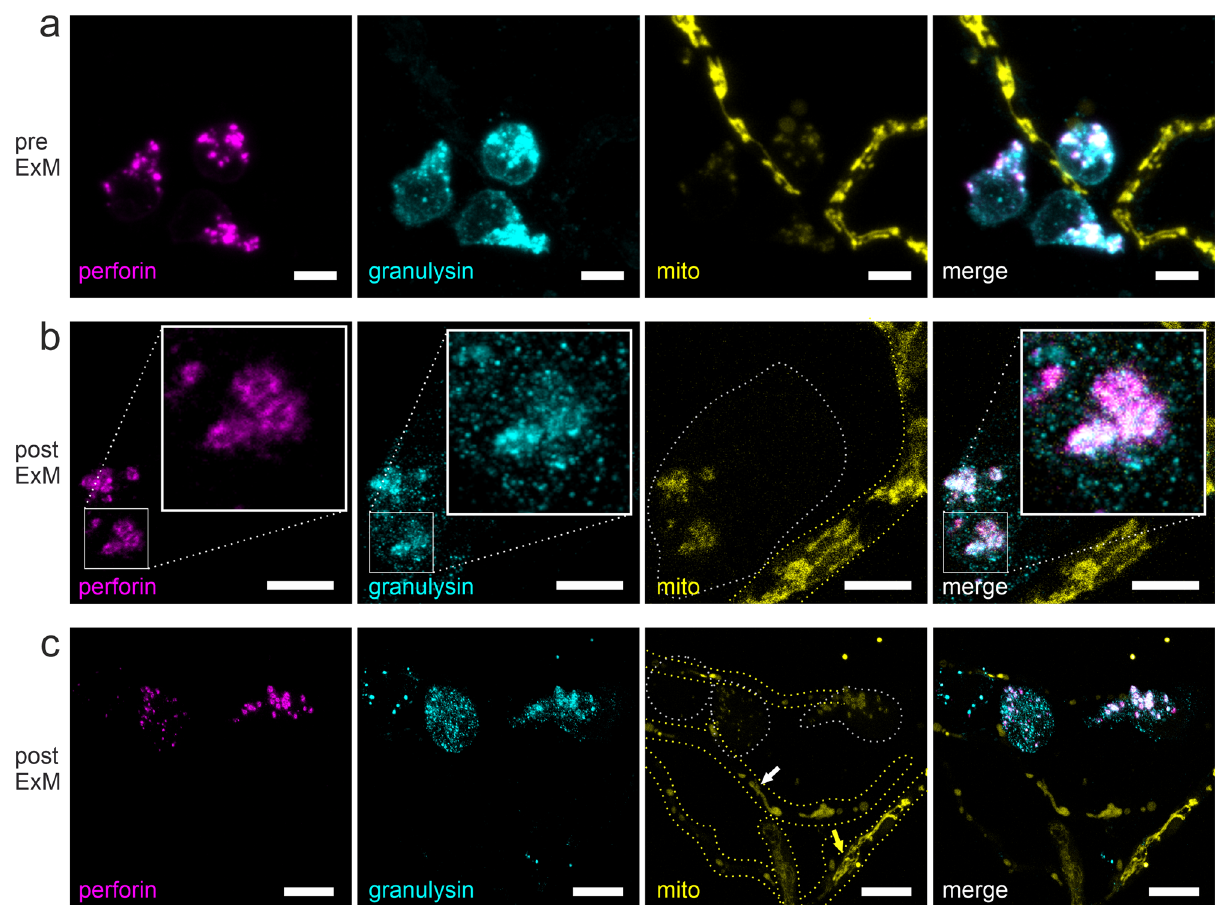
Fig. 3 Visualization of NK-cells lytic granules after 5.5 h coculture with A. fumigatus hyphae. Perforin (magenta) and granulysin (cyan) were visualized by antibody staining, fungal hyphae via RFP-expressing mitochondria (yellow). a Conventional CLSM images prior to expansion. Perforin and granulysin are partially overlapping in round-shaped granules. b ExM images. Post ~4x expansion, labeled perforin appears as a ring-like structure, whereas granulysin was also distributed throughout the NK cell. Insets in panel b represent a detailed view of the indicated region. c Effect of degranulation. In the direct environment of degranulating NK cells, mitochondria appear distorted or even absent (white arrow) in comparison to hyphae more distant (yellow arrow). All images represent maximum intensity z-projections. Dotted lines indicate borders of NK cells (gray) and fungal hyphae (yellow). Representative images of at least three biological replicates. Scale bars, 5 µ m ( a ), 10 µ m ( b ), and 25 µ m ( c